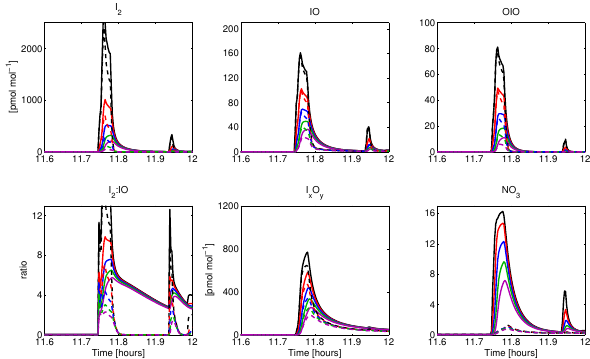
Fig. 11. Non-seasalt aerosol properties for the I 2 recycling, low tide, model run. Top panel is the dry mole fraction of NO − a height of 0.5m. Bottom panel is total dry volume of the non- seasalt mode at heights of 0.5, 8, 60, 250 and 650m (black, red, blue, green, and purple lines, respectively).